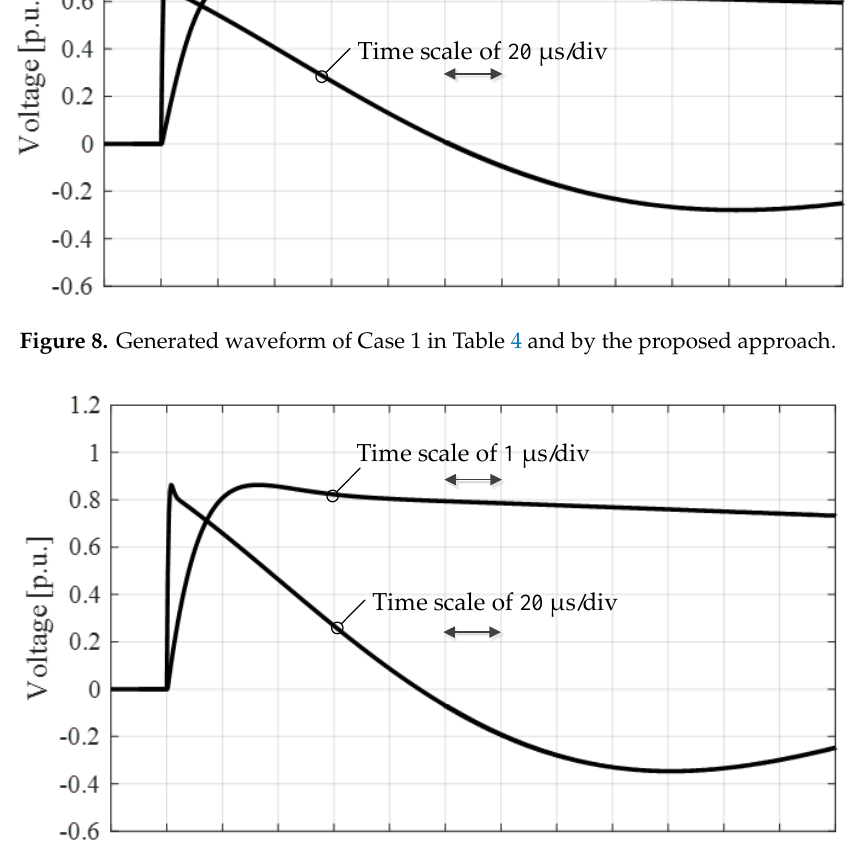
Figure 9. Generated waveform of Case 3 in Table 4 and by the proposed approach.